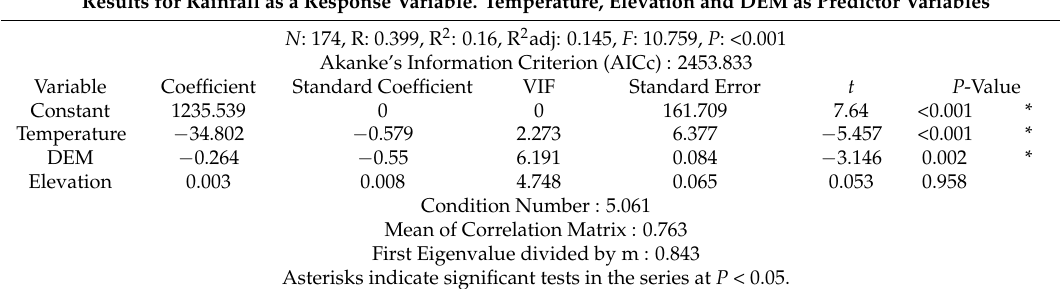
Table 8. Results of the OLS